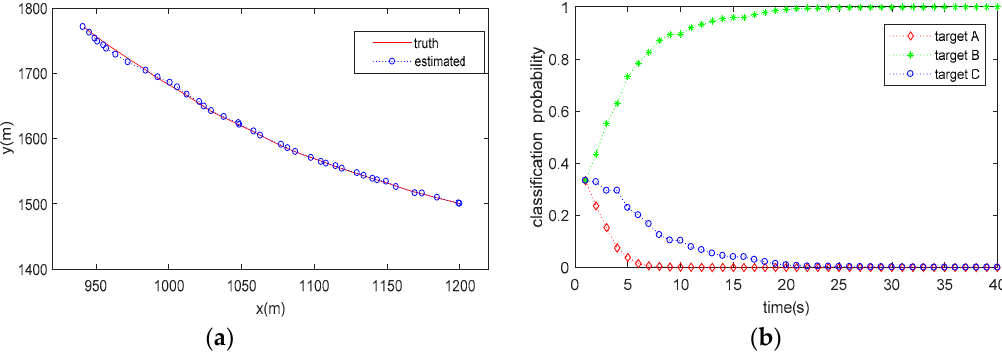
Figure 4. Result of JTC when Target Class B is present: ( a ) estimated target trajectory; ( b ) estimated target class probability.